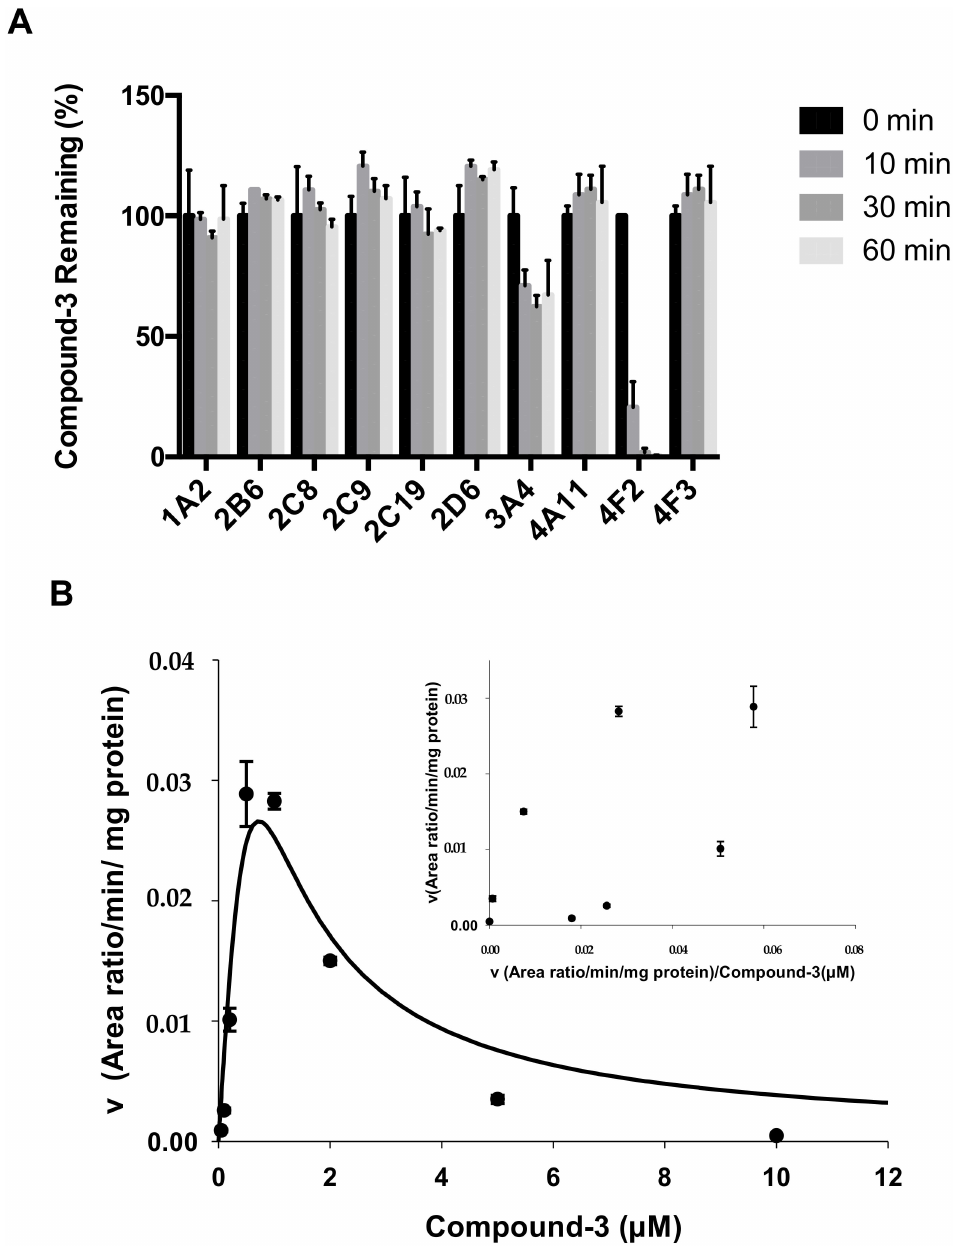
Figure 5. Metabolism of Compound- 3 by CYP isozymes. ( A ) Formation of M4 (carboxylic acid) in incubations of Compound- 3 (1 µ M) with various CYP isozymes (50 nM) (n = 3); ( B ) Formation kinetics of M4 in CYP4F2 when Compound- 3 was incubated with CYP4F2 (10 nM) at various concentration levels for 10 min (n = 3); inset, Eadie-Hofstee